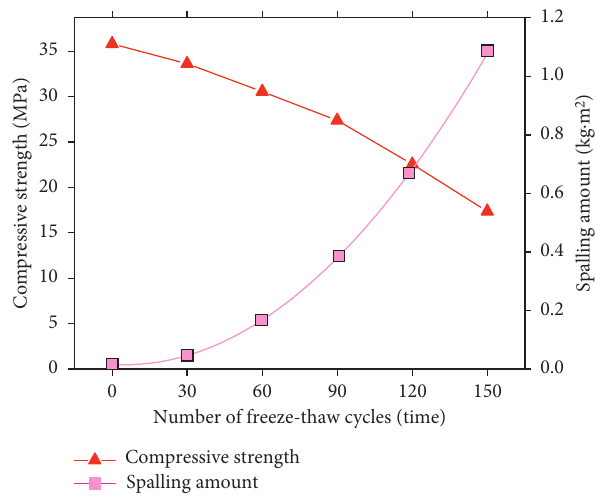
Figure 6: Variation curve of CRC spalling